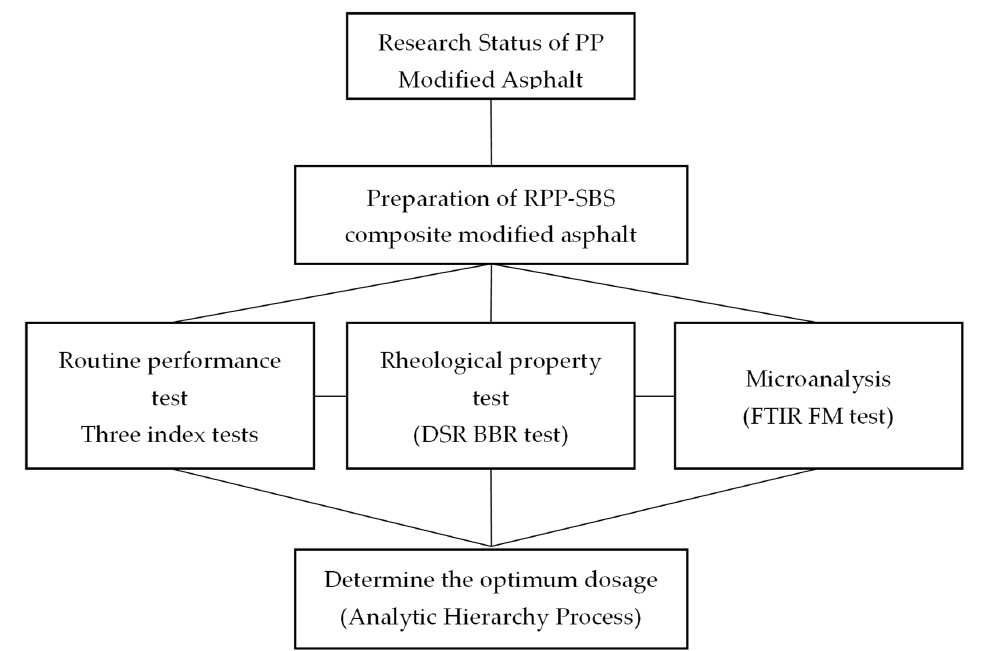
Figure 1. The design process of this study.